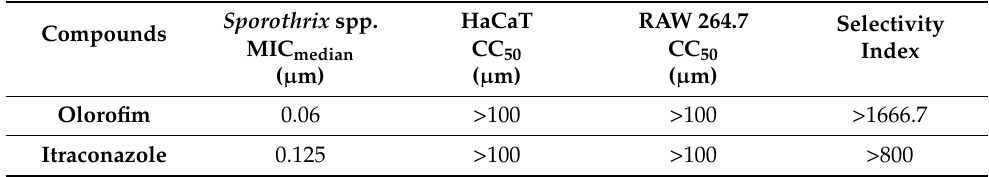
Table 2. Cytotoxicities of olorofim and itraconazole.